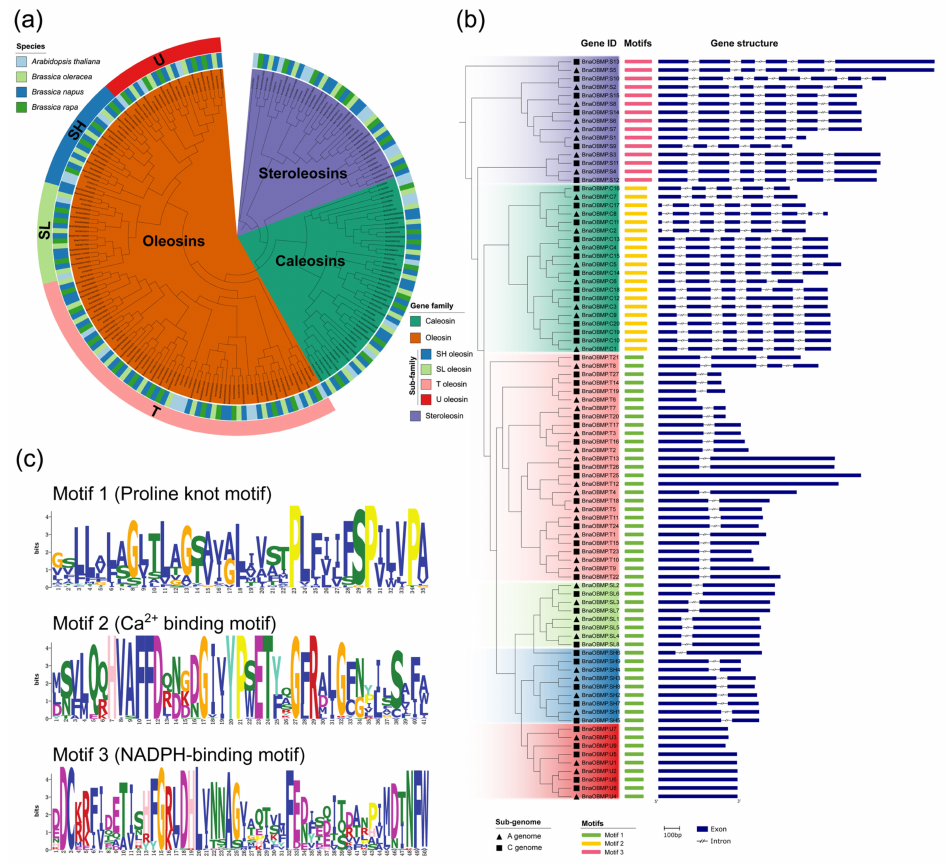
Figure 2. Phylogenetic relationships, motifs and gene structures of BnaOBMPs . ( a ) Phylogenetic relationships of BnaOBMPs , BraOBMPs , BolOBMPs and AtOBMPs . The unrooted tree was generated using IQ-TREE software by the ML method. The outermost track represents the subfamily of oleosins including U (red), SH (blue), ST (light green) and T (pink) oleosins. The middle track marks the species by the corresponding colors shown in the color legend at the top left. The inner track represent the ML tree and the phylogenetic classes of OBMP genes including oleosins (orange), caleosins (green) and steroleosins (light blue). The color legend for the OBMP gene family is shown at the bottom right. ( b ) A schematic diagram of the exon–intron organization of OBMP genes in B. napus . The phylogenetic tree of BnaOBMPs is placed at the left, and the background colors represent phylogenetic classes. The black triangles and squares represent BnaOBMP genes in the A and C sub genomes of B. napus , respectively. The blue boxes and shrunken lines indicate exons and introns, respectively. The length scale bar is 100 bp. The diverse conserved motifs of BnaOBMPs are marked by different colored boxes including Motif 1 (green), Motif 2 (yellow) and Motif 3 (pink). ( c ) The conserved domain sequence model of Motifs 1, 2 and 3. Motif 1 is a proline knot motif including four invariable residues of the proline knot sequence (-PX 5 SPX 3 P-). Motif 2 is a Ca 2+ -binding motif. Motif 3 is an NADPH-binding